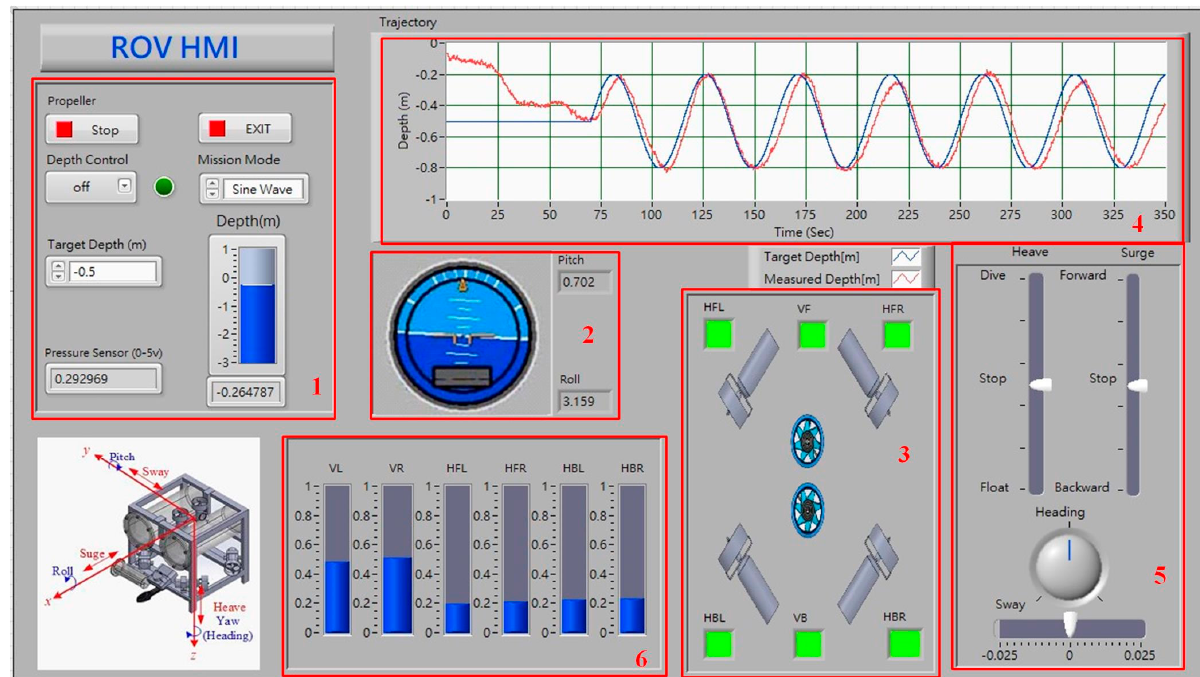
Figure 8. Schematic diagram of the ROV HMI.